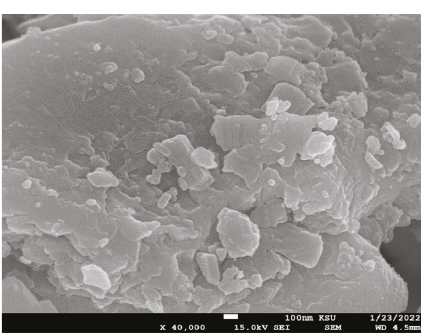
Figure 16: SEM image of Nd